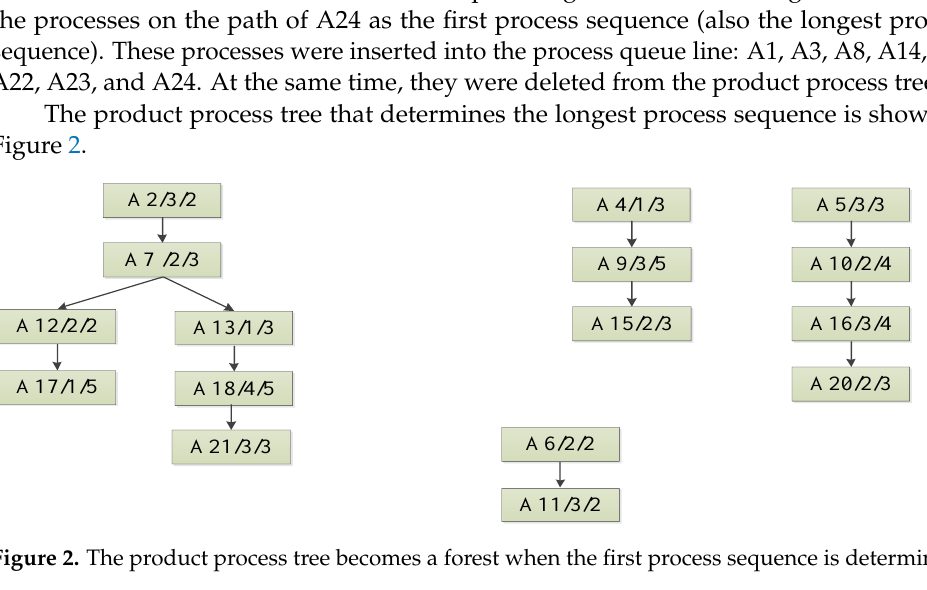
Figure 1. Product A processing process tree.